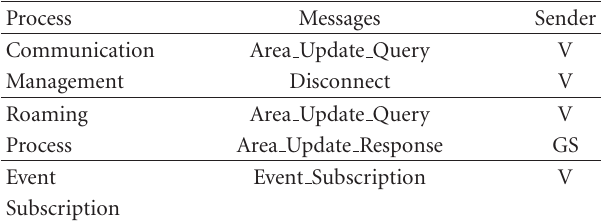
Table 1: Vehicle-Group Server communication.